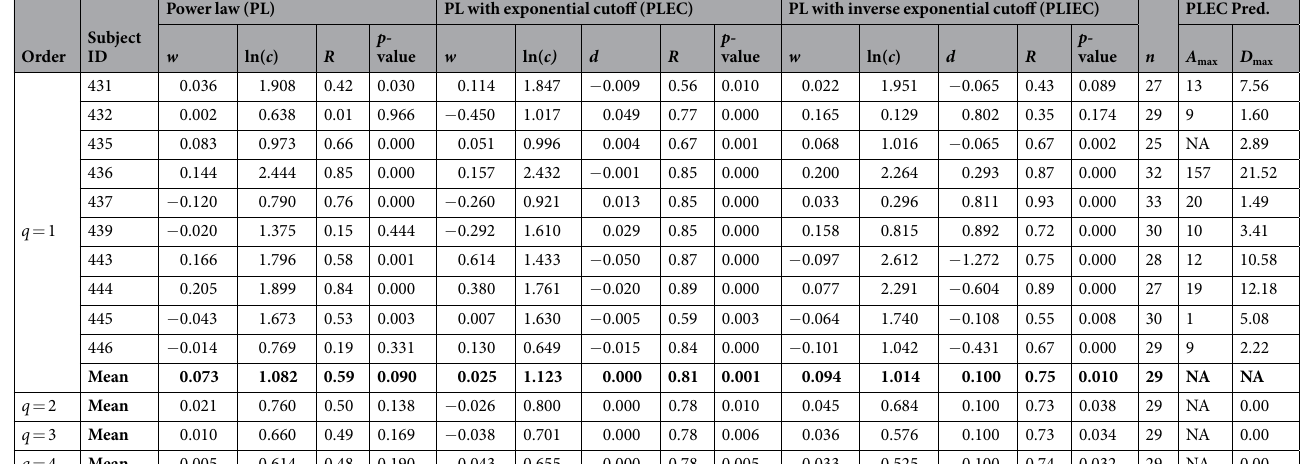
Table 1. The Alpha-Diversity Time Relationship ( A DTR) models for the individuals in the 32-healthy cohort * . * Only the A DTR models for q = 0 & 1 and the mean parameters for the whole cohort for q = 2–4 are listed here; to save page space the full results for q = 2–4 are presented in Suppl. Table